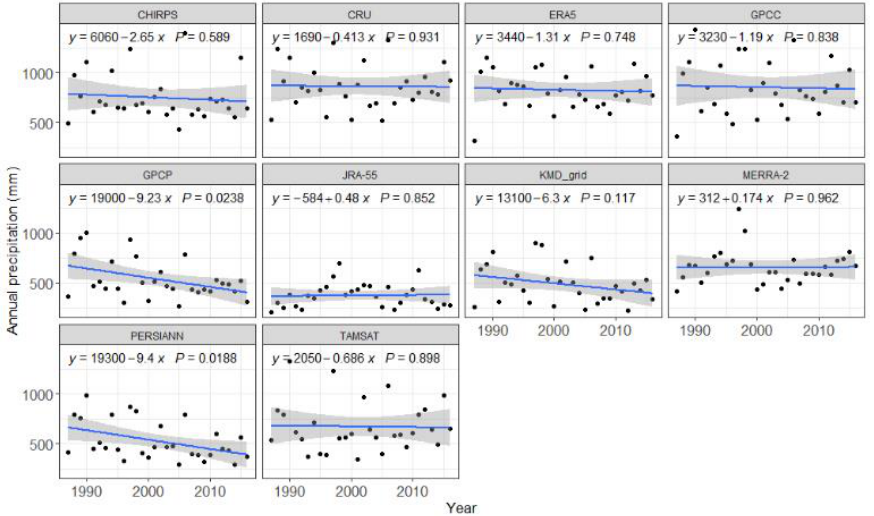
Figure 5. Non-significant annual precipitation trends in the 10 products. The back dots represent annual precipitation values with the blue line indicating the linear regression.